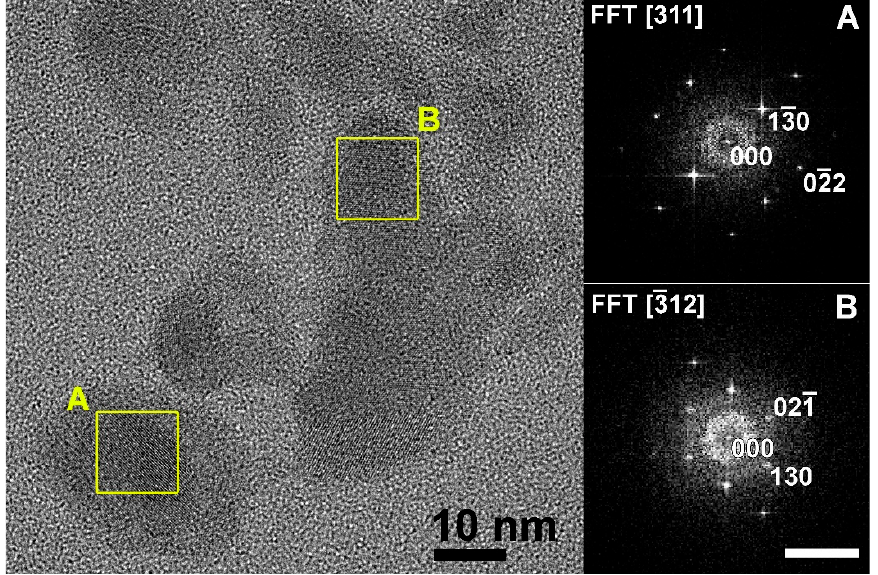
Figure 4. HRTEM image of Ba(Y 0.964 Yb 0.030 Er 0.006 ) 2 F 8 NPs ( A ) and ( B ) their corresponding diffracto- grams obtained along directions close to [311] and [ 3(cid:3364) 12]; the scale bar on the diffractograms corre- sponds to 5 nm − 1 .